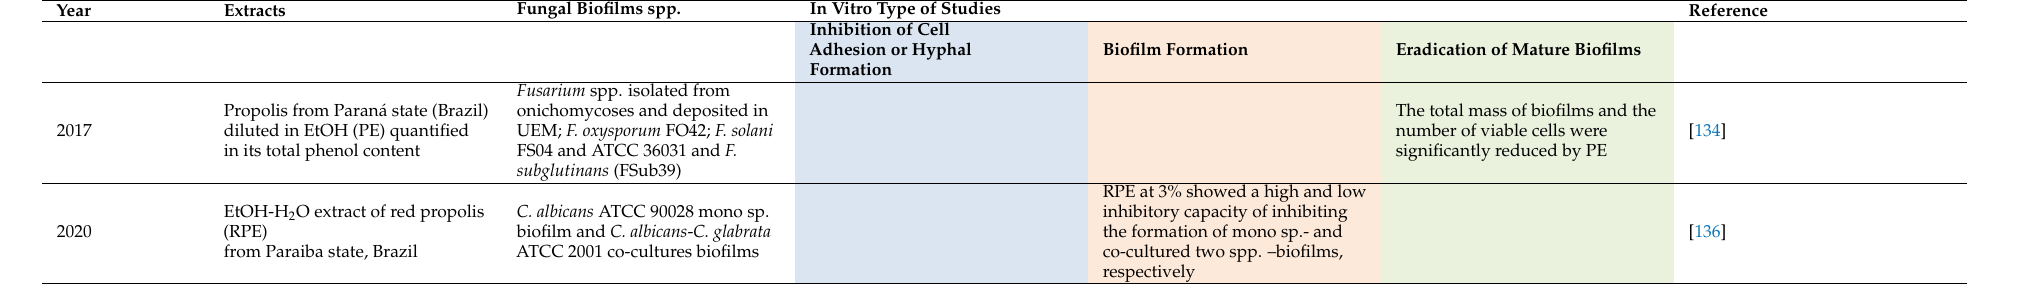
Table 2. More relevant results of propolis extracts showing a capacity for inhibiting fungal biofilms.